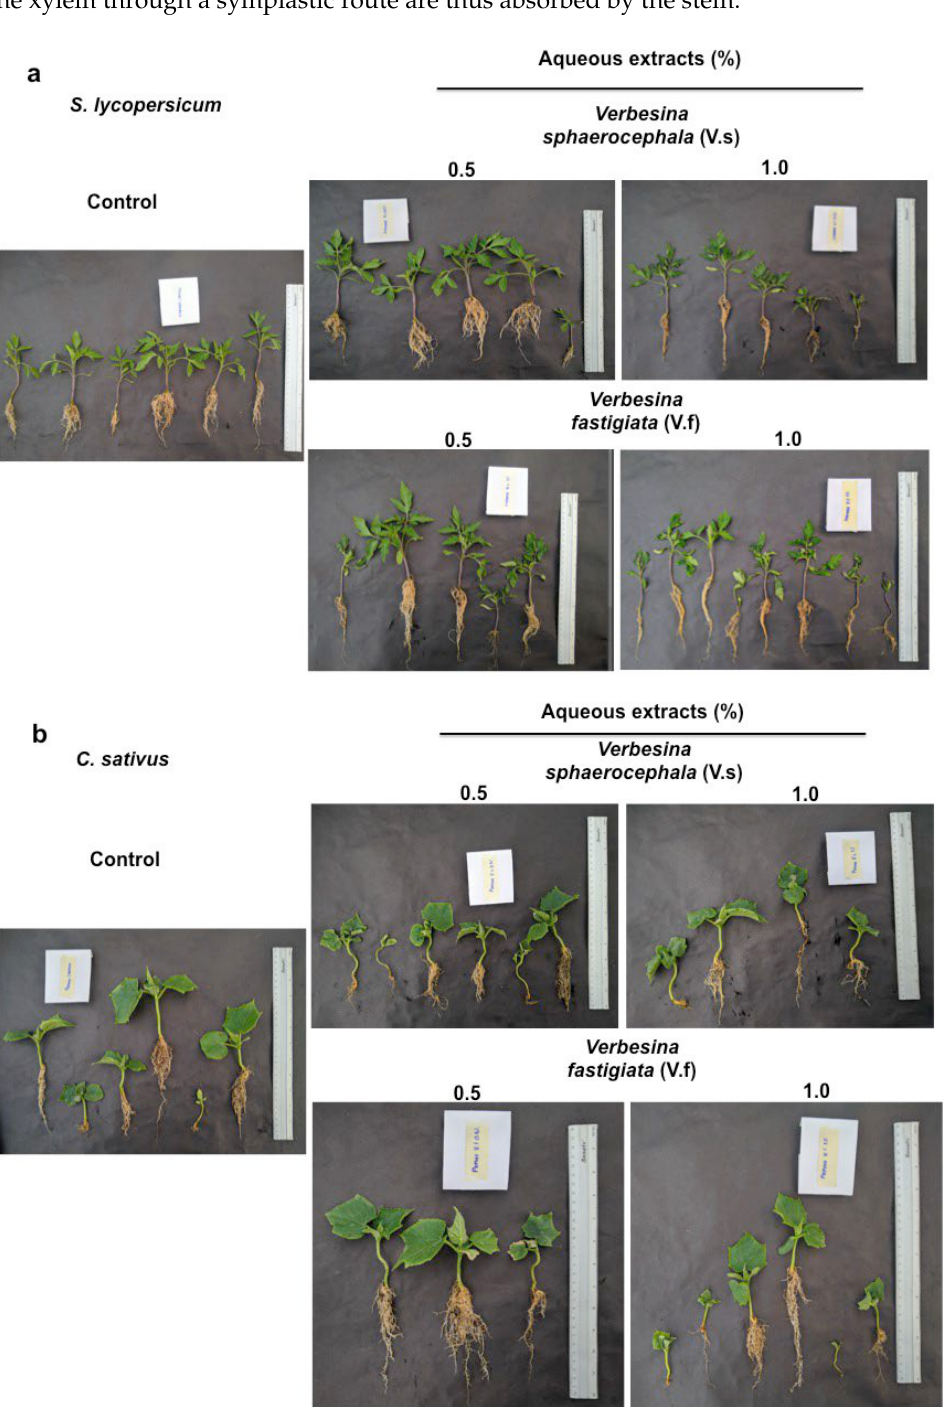
Figure 7. Differences in the development of seedlings in the nursery among treatments. Develop- ment of ( a ) Solanum lycopersicum and ( b ) Cucumis sativus seedlings with the application of extracts from Verbesina sphaerocephala and Verbesina fastigiata at concentrations of 0.5 and 1%.